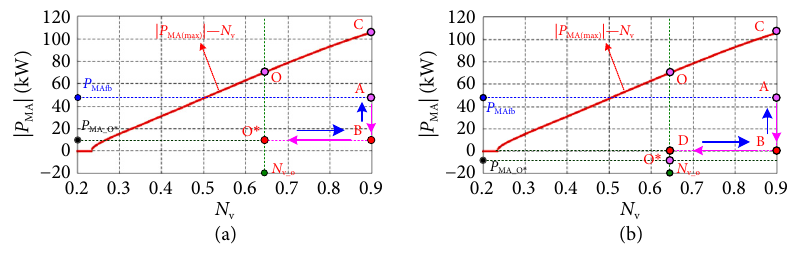
⩾ Fig. 8 Active-power regulation path during LVRT transition in the power-consumption state. (a) P MA_O * 0. (b) P MA_O * < 0.